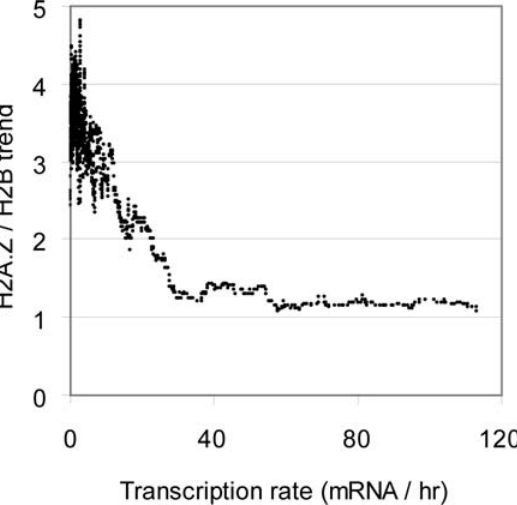
Figure 3. H2A.Z/H2B Ratios Are Inversely Correlated with Transcription Rate The binding trend was calculated by computing the moving median of the H2A.Z/H2B flat ratios over a sliding window of 50 genes across all genes ordered by transcription rate as described previously [36,40,41,60– 62]. Each probe was assigned to its closest ATG, and the probe with the highest H2A.Z/H2B value for each gene was used. The transcription rate for yeast genes was determined previously [63]. DOI: